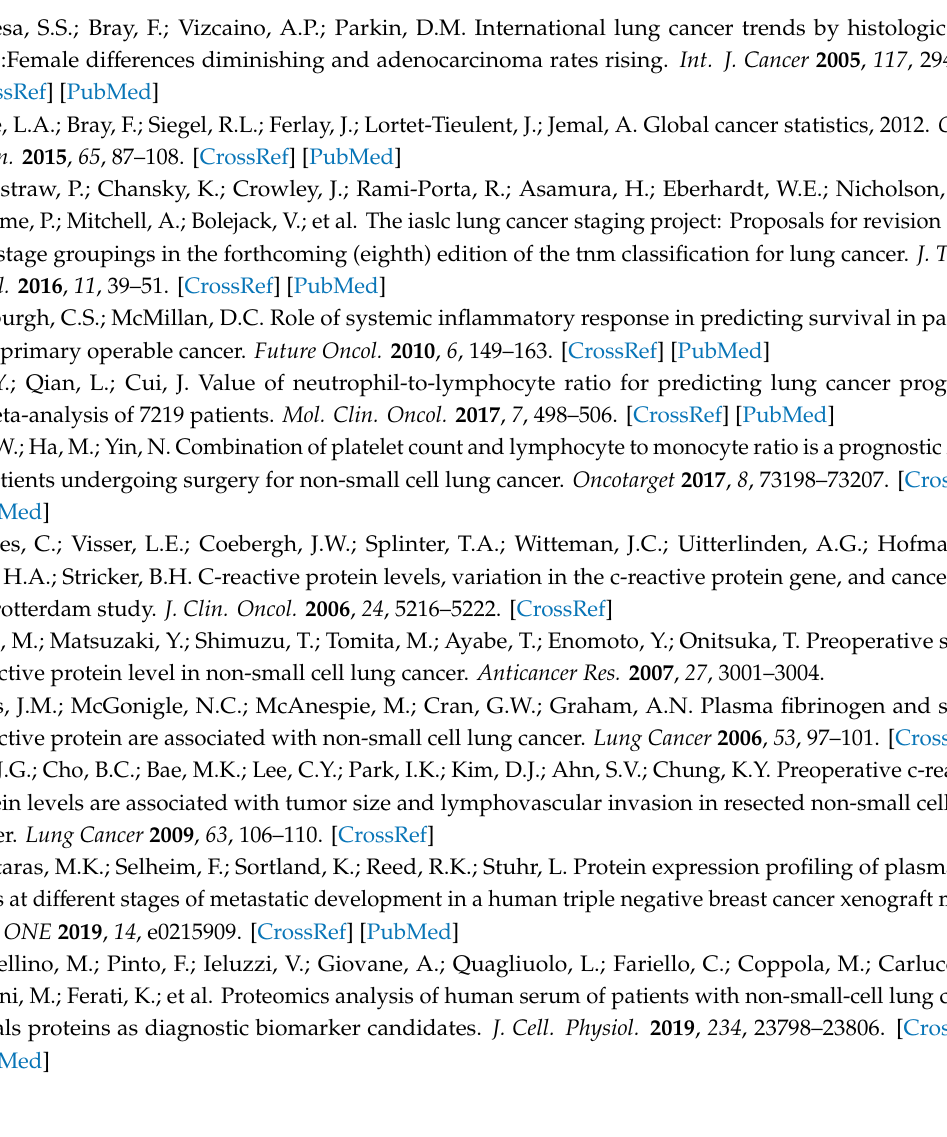
Figure S5: Expression of SERPINA1 in NSCLC cell lines and annexin V assay; Figure S6: Controls for siRNA knockdown and overexpression of SERPINA1 in H1975 and H661 cells. Table S1: Gene ontology enrichment results for H1975 and H661